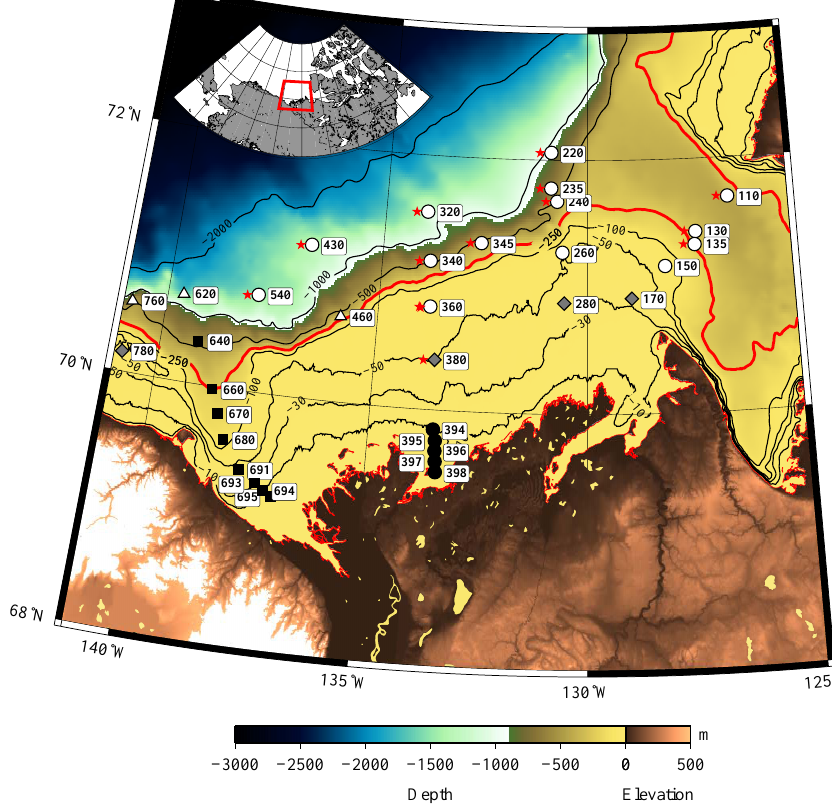
Fig. 1. Map of the sampling area of the Malina Leg2b cruise (31 July to 29 August 2009). The meaning of symbols for stations is given in legend of Fig.